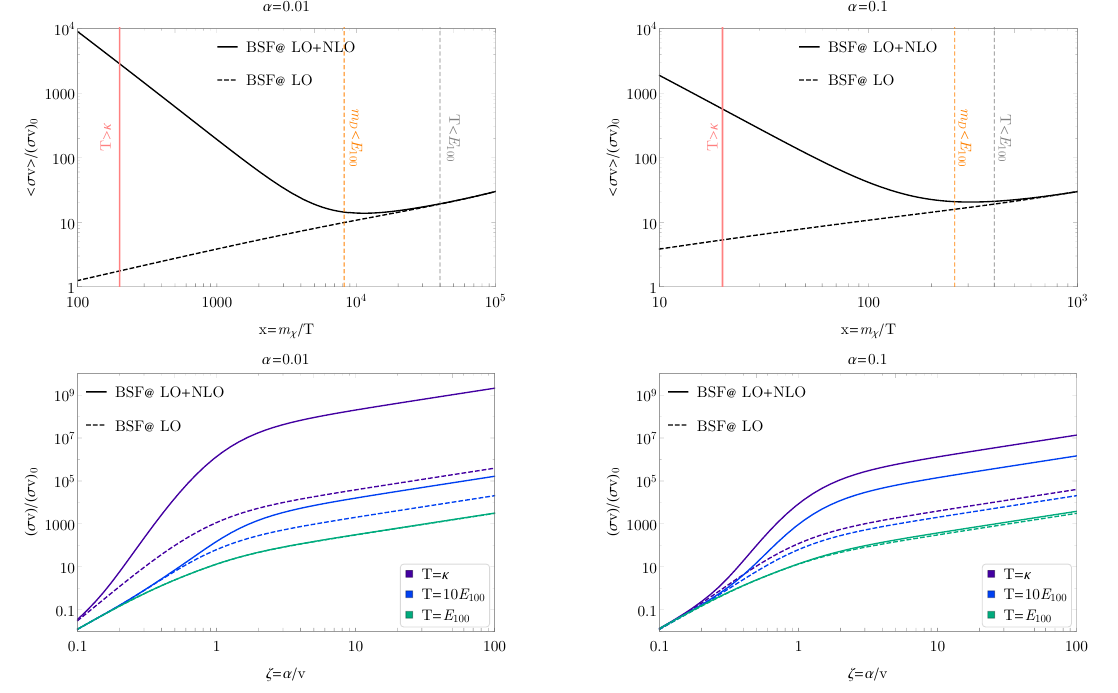
Figure 5 . Lower row shows the bound-state formation cross sections. Upper row compares the ther- mally averaged quantities. The cross sections are normalized to ( (cid:27)v ) 0 (cid:17) (cid:25)(cid:11) 2 =m 2 the vertical lines indicate when temperature is larger than the Bohr momentum (cid:20) = (cid:22)(cid:11) , the electric Debye mass m 2 = g 2 T 2 = 3 and the temperature are smaller than the ground state binding energy. D